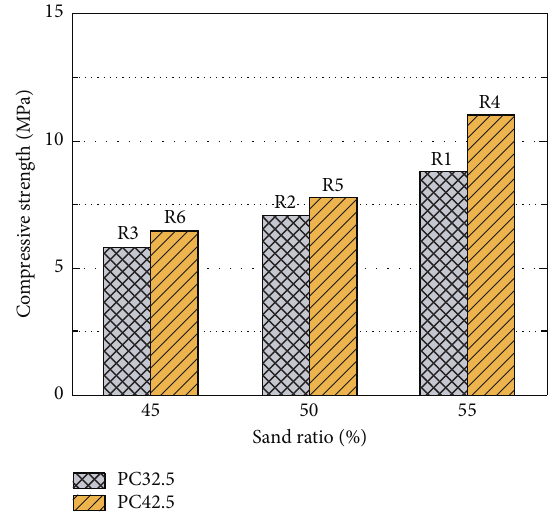
Figure 5: Effect of sand rate on compressive strength.